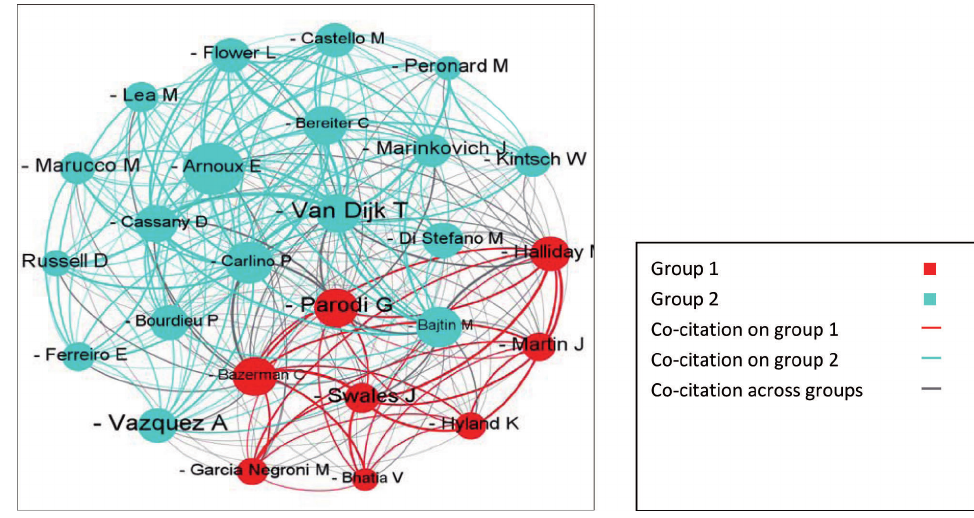
Figure 4: Co-citation network of most cited authors Nodes represent the authors, colour coded according to the community detection modularity analysis powered by the software. Lines indicate that two nodes were cited together. Combined colours in lines show co-citation between nodes that belong to different communities. The thicker the line, the more connections exist between the two nodes. For instance, people cite together Parodi and Carlino, Lea and Bazerman, and Cassany and Parodi, even when they do not belong to the same grouping. The size of the nodes represents their weight in the network. That is, the bigger the circle, the higher the number of authors with whom the node was co-cited. Figure 4 does not indicate number of citing papers, but rather number of connections between